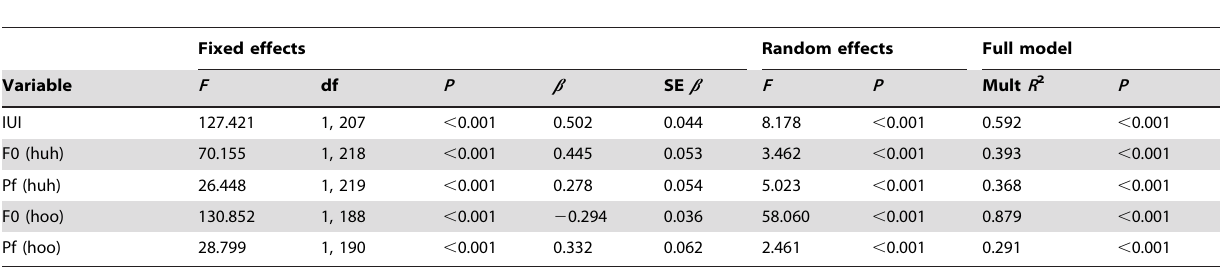
Table 2. Variation in relation to call unit position within the loud